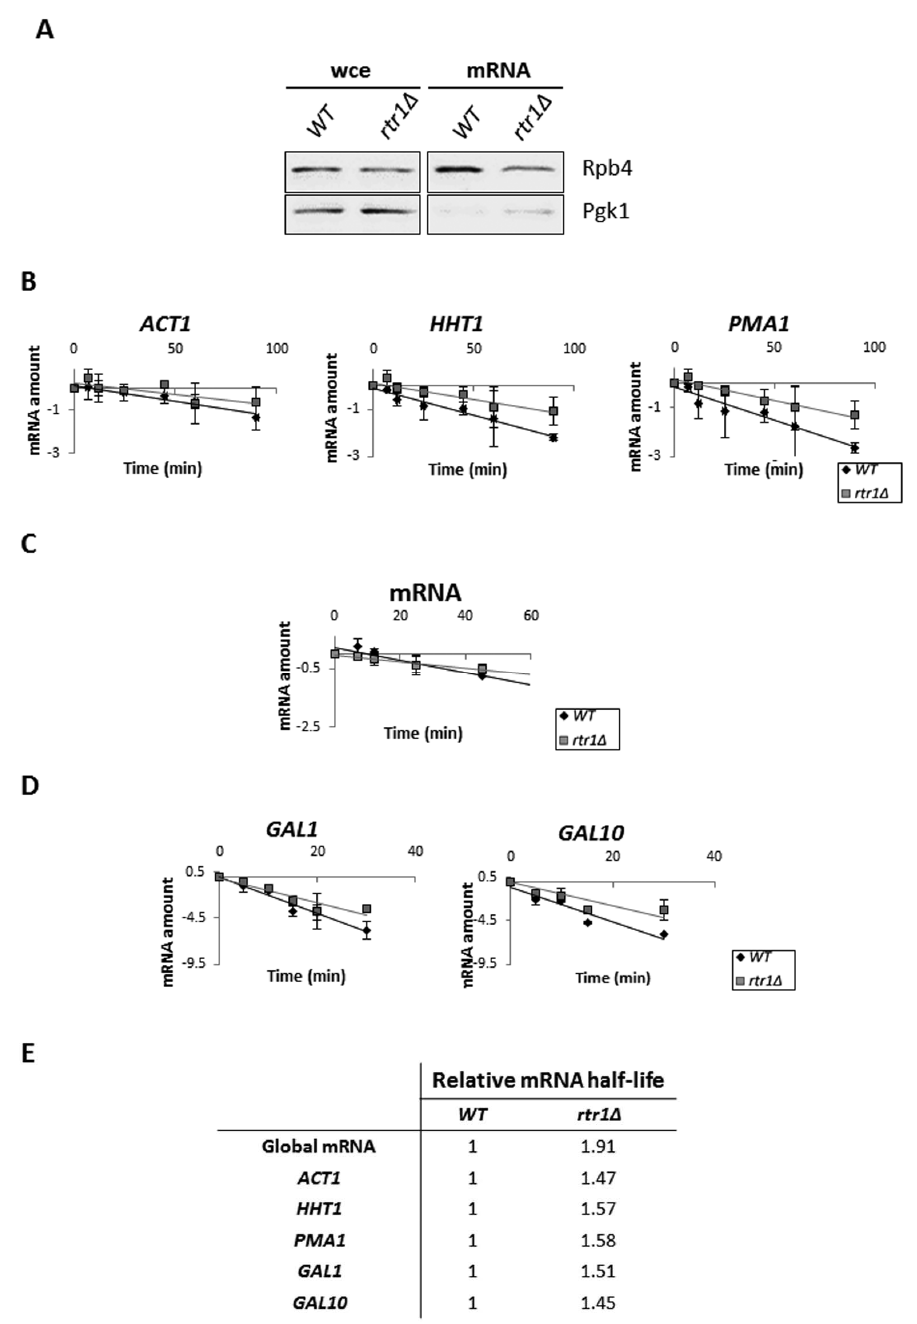
Figure 5. rtr1 ∆ decreases Rpb4-mRNA imprinting and increases mRNA stability. ( A ) Western blot of Rpb4 in both whole-cell free extracts and oligo-dT purified mRNAs after exposure to 1200 mJ/cm 2 of 254 nm UV in wild-type and rtr1 ∆ mutant. Anti-Pgk1 antibody was used as a negative control. ( B ) mRNA levels, measured by RT-qPCR, for genes ACT1, HHT1, and PMA1 after thiolutin addition to block transcription in wild-type and rtr1 ∆ mutant. ( C ) Global mRNA levels measured at different times after thiolutin addition to block transcription in wild-type and rtr1 ∆ mutant using an oligodT probe by a dot-blot assay. ( D ) GAL1 and GAL10 mRNA amounts measured by RT-qPCR, in wild-type and rtr1 ∆ mutant at different times after blocking transcription with glucose. Time 0 corresponded to cells grown in presence of galactose as carbon source. In ( B – D ), drop in mRNA levels after shutoff at different times is represented on a natural logarithmic scale. In ( B , D ), rRNA 18S was used as a normalizer. ( E ) Relative mRNA half-lives calculated from experiments represented in ( B – D ). All experiments corresponded to at least three independent biological